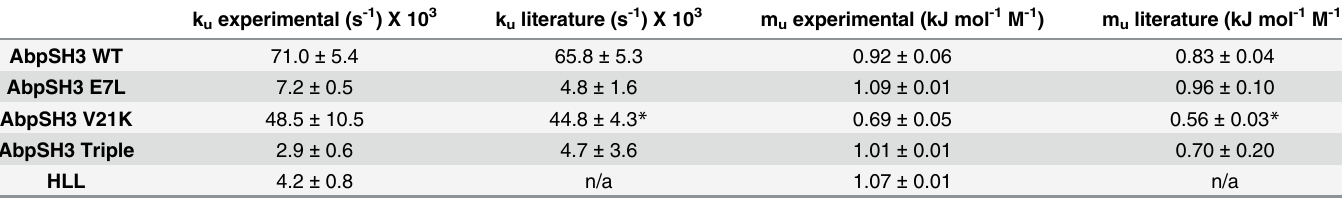
Table 1. Summary of kinetic unfolding data collected using the plate reader method.